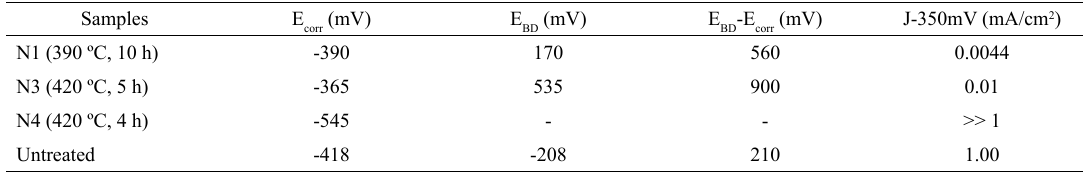
Table 4. Corrosion results (Anodic polarization)